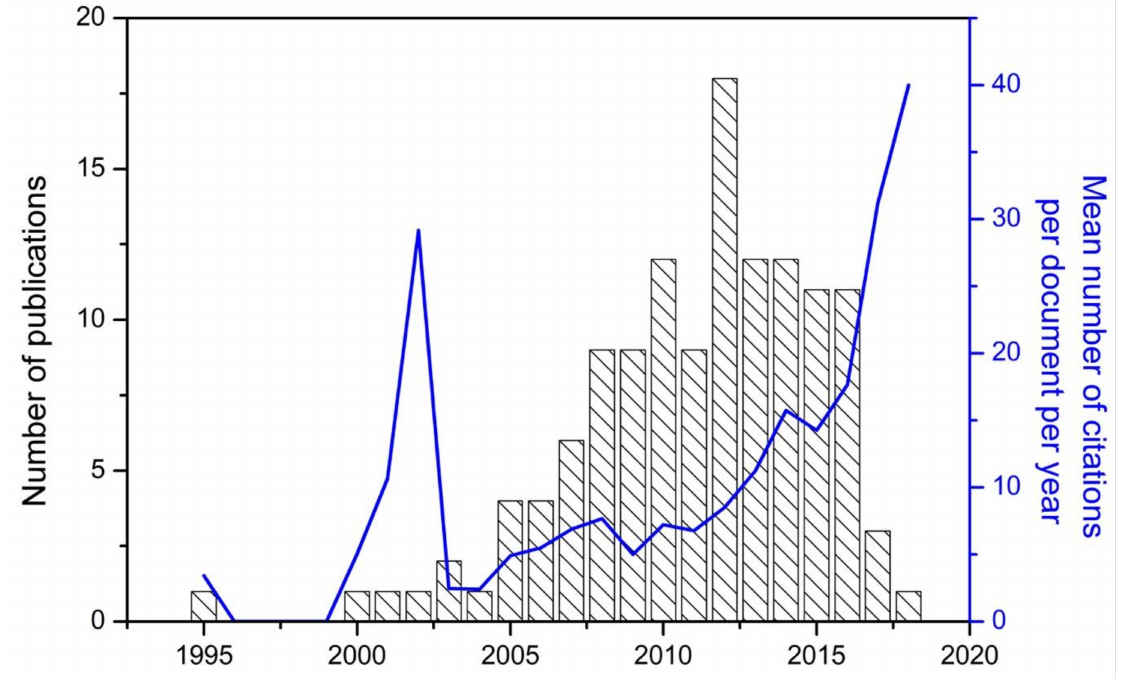
Figure 3. Temporal evolution of analysed